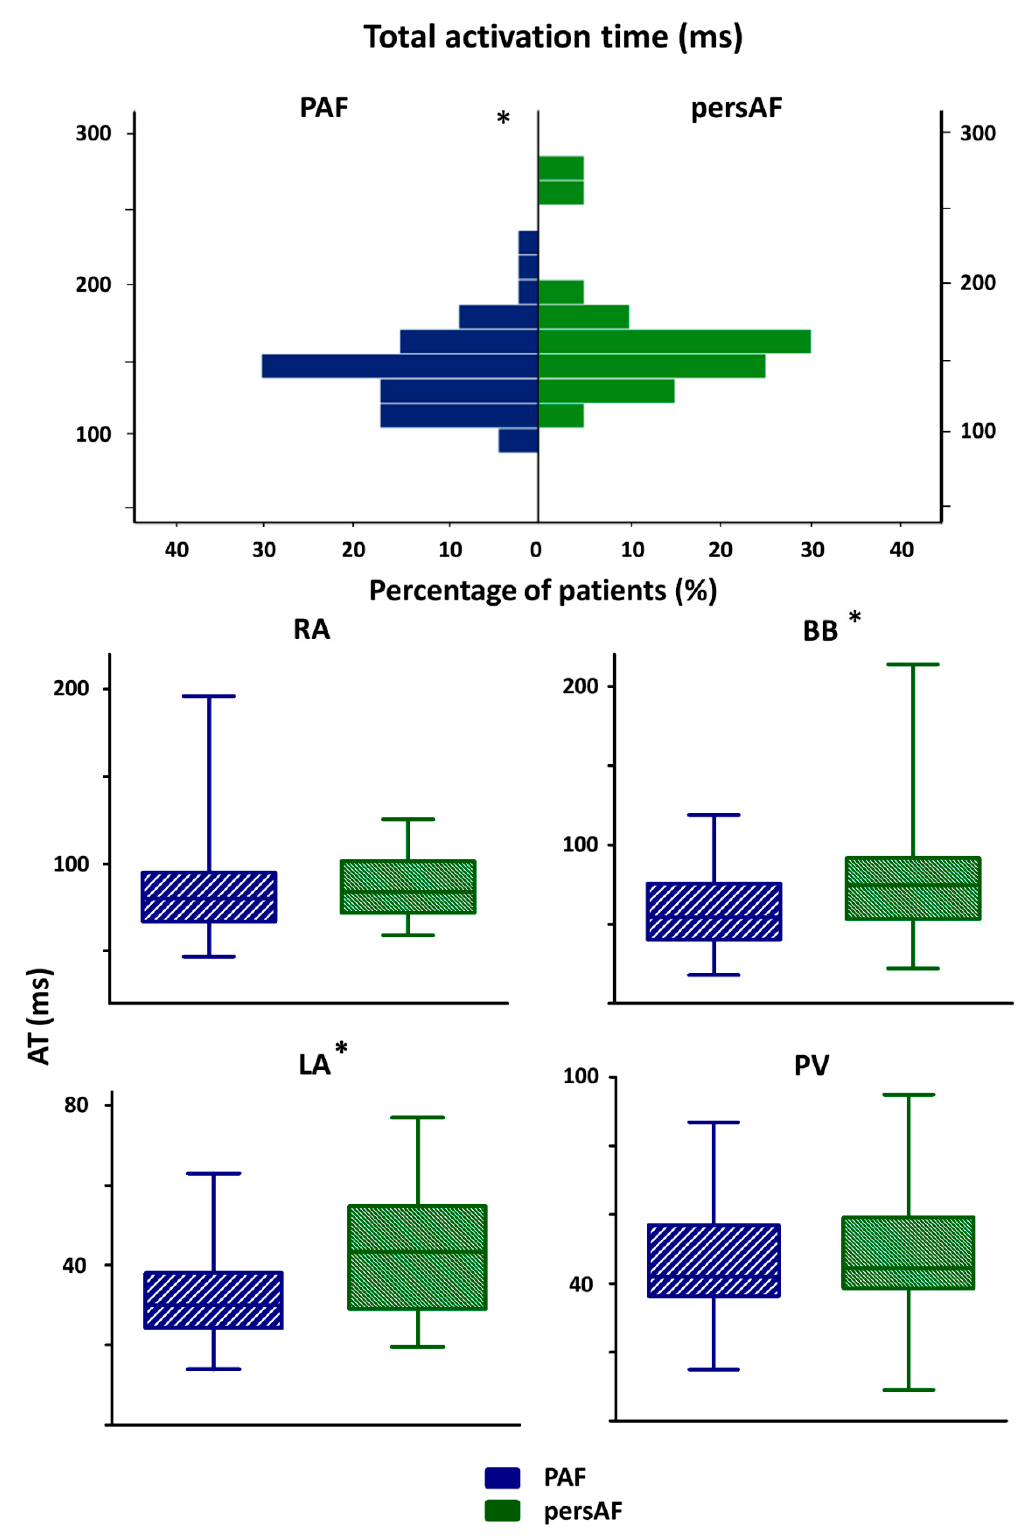
Figure 3. Paroxysmal vs. persistent AF patients: activation times. The upper panel shows the distribution of total activation time for the PAF group and persAF group. The lower panel depicts ATs for each location separately in the PAF and persAF group. BB: Bachmann’s bundle; LA: left atrium; PVA: pulmonary vein area; PA: paroxysmal AF; persAF: persistent AF; RA: right atrium; AT: activation time; * total activation time; p = 0.034, BB: p = 0.017, LA: p = 0.010.